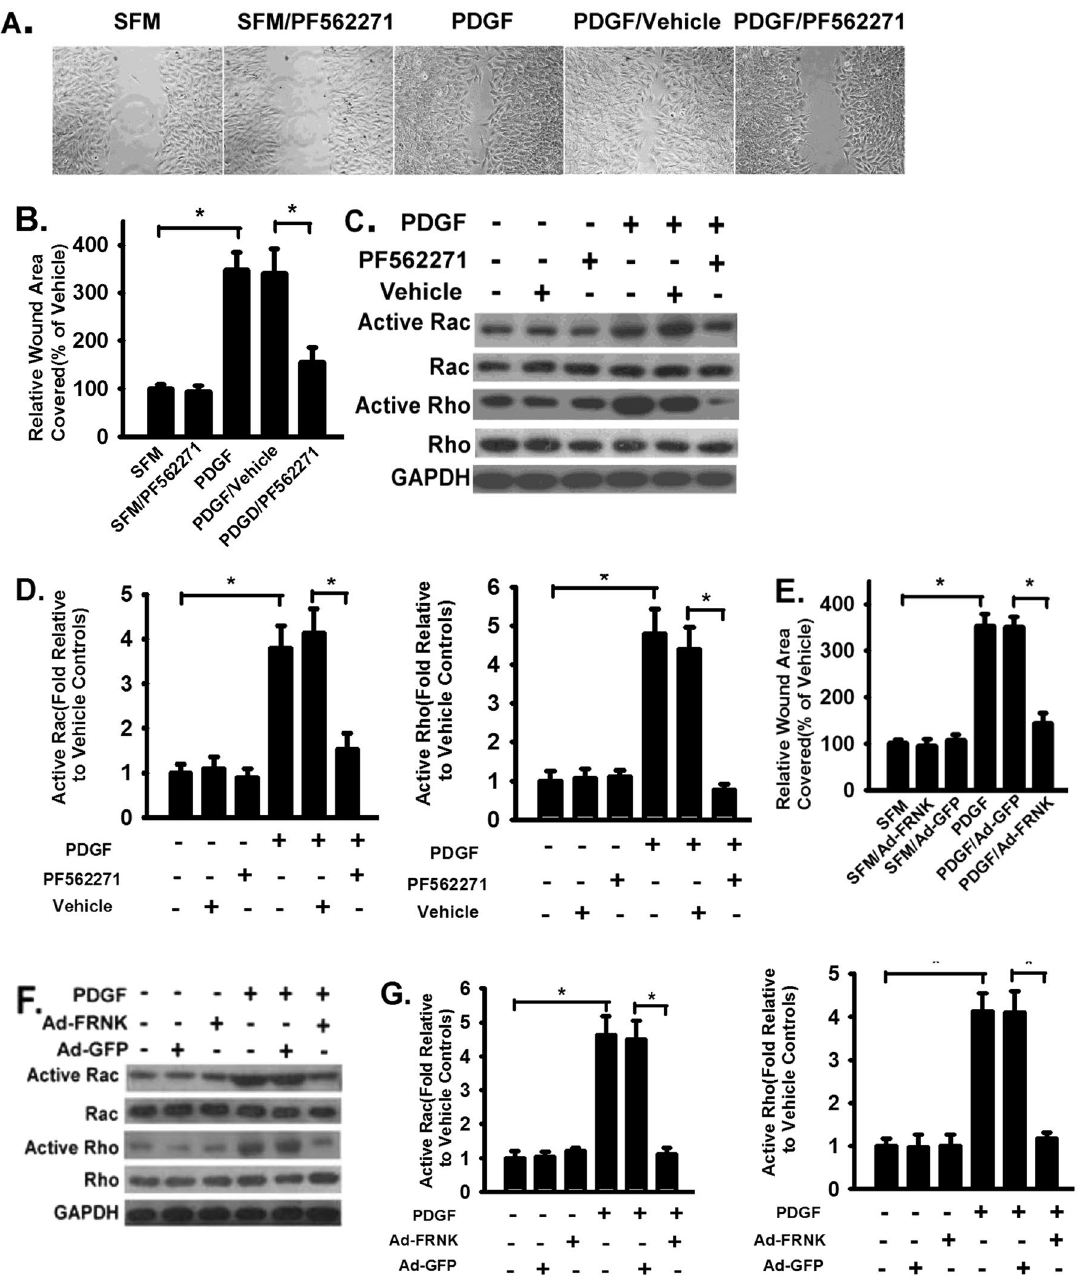
Figure 4. FAK inhibition significantly reduces HSC migration and inhibited the activation of Rac and Rho in response to platelet derived growth factor BB (PDGF-BB). ( A ) Primary mouse HSCs were serum starved for 20 hours and HSC migration in response to PDGF-BB (PDGF, 4 ng/ml) in serum-free medium with 1% BSA (SFM) with FAK inhibitor (PF562271, 0.5 µ M) or vehicle was examined by wound closure assay for 24 hours. Representative images were shown (10X). Migration in SFM condition was almost not observed. Image at 0 in SFM (first image) was used to quantify the migration. Other images were taken at 24 hour for the indicated conditions. ( B ) Data are pooled and shown as % of wound area covered by cells over 24 hours, relative to that of uninfected WT fibroblasts in SFM medium. ( C ) HSCs were treated as in panel A and lysed at 24 hours. Equivalent amount of whole cell detergent lysates were used for detection of Rac and Rho activation. ( D ) Densitometry analysis of the effect of FAK inhibitor on Rac and Rho activation at the indicated condition. ( E ) Cells were infected with adenoviral vectors containing FRNK or control GFP, treated as in panel A, and migration was examined by wound closure assay for 24 hours after PDGF-BB (PDGF, 4 ng/ml) treatment. Data were pooled and represented as in panel B. ( F ) HSCs were treated as in panel E and lysed at 24 hours for activation of Rac and Rho. ( G ) Densitometry analysis of the effect of FRNK expression on Rac and Rho activation at the indicated condition. Data were pooled from three independent experiments and represented as mean ± SE. * p represents <